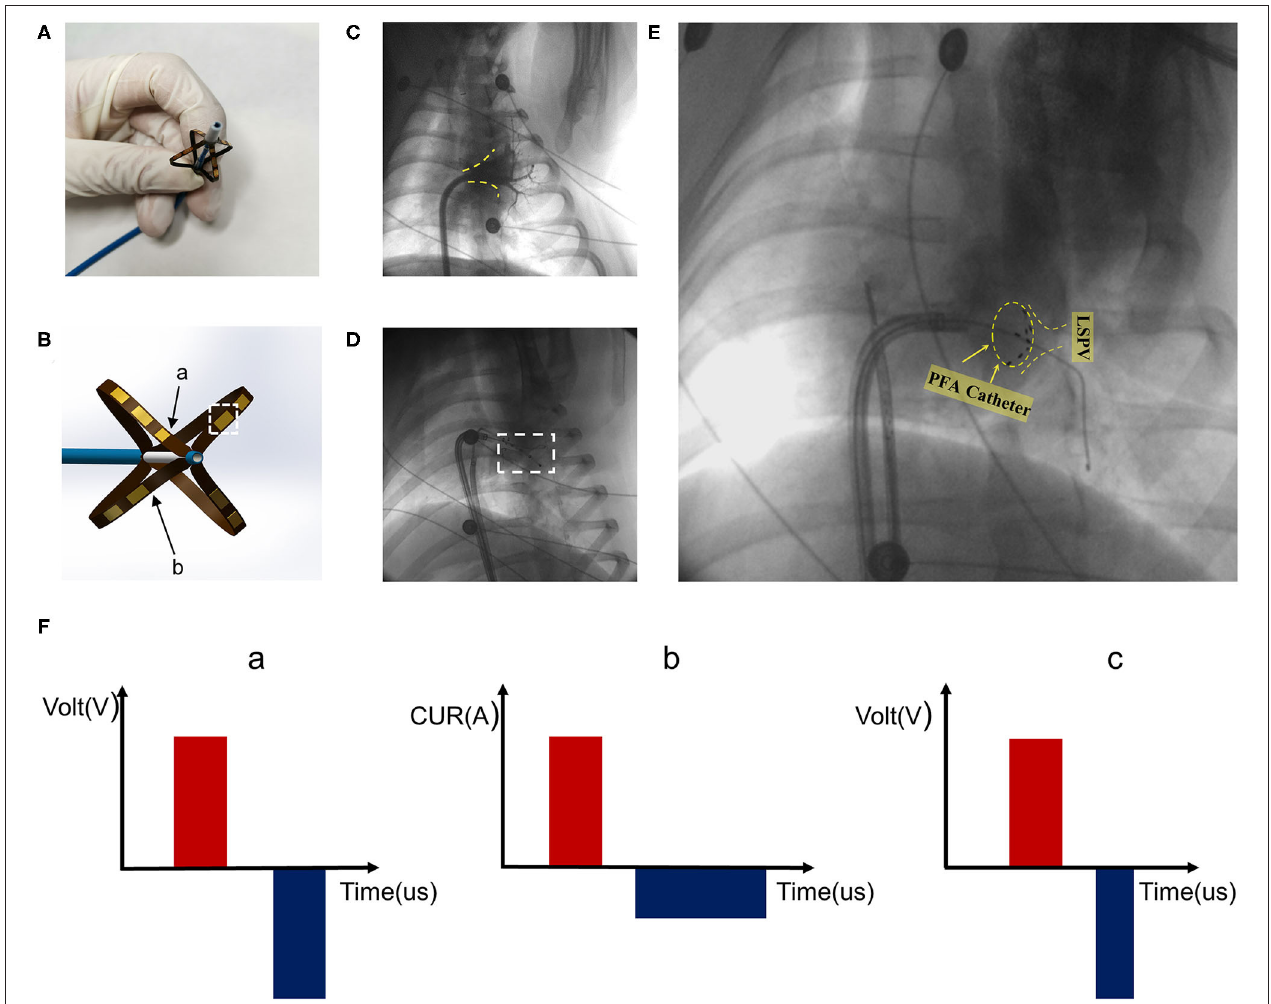
FIGURE 1 | Pulsed field ablation system. (A) Biphasic asymmetric pulsed field ablation catheter in open state. (B) Illustration of the front end of the ablation catheter. Arrow a is the positioning electrode. Arrow b refers to the catheter frame. The white dotted box represents the electrode. (C) Left superior pulmonary angiography. Yellow dotted line marking the contour. (D) Pacing after ablation. (E) PFA catheter for ablation at the left superior pulmonary vein ostia. PFA catheter shape shown in yellow dotted circle. (F) Pulsed field ablation mode. Mode c is biphasic asymmetric pulsed field